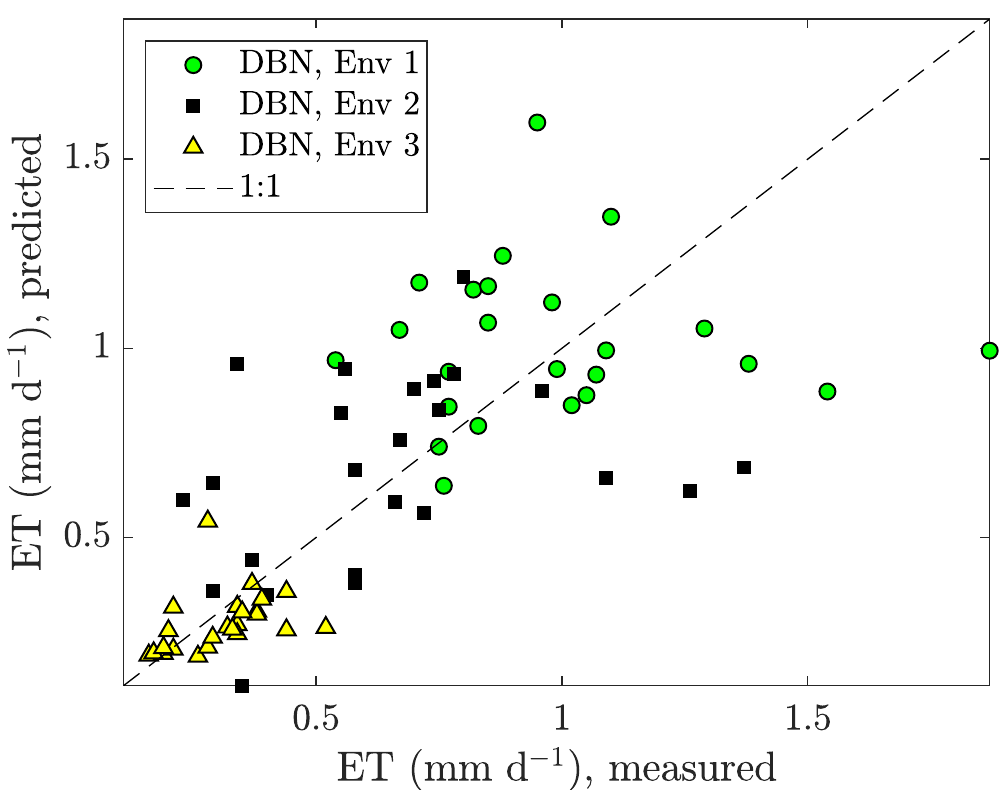
Figure 5. Measured vs. predicted measurement data obtained by our DBN application for the micro- tomatoes in three different environments: Env 1 (warm and bright), Env 2 (shaded and emergency heating), and Env 3 (indoor and artificial